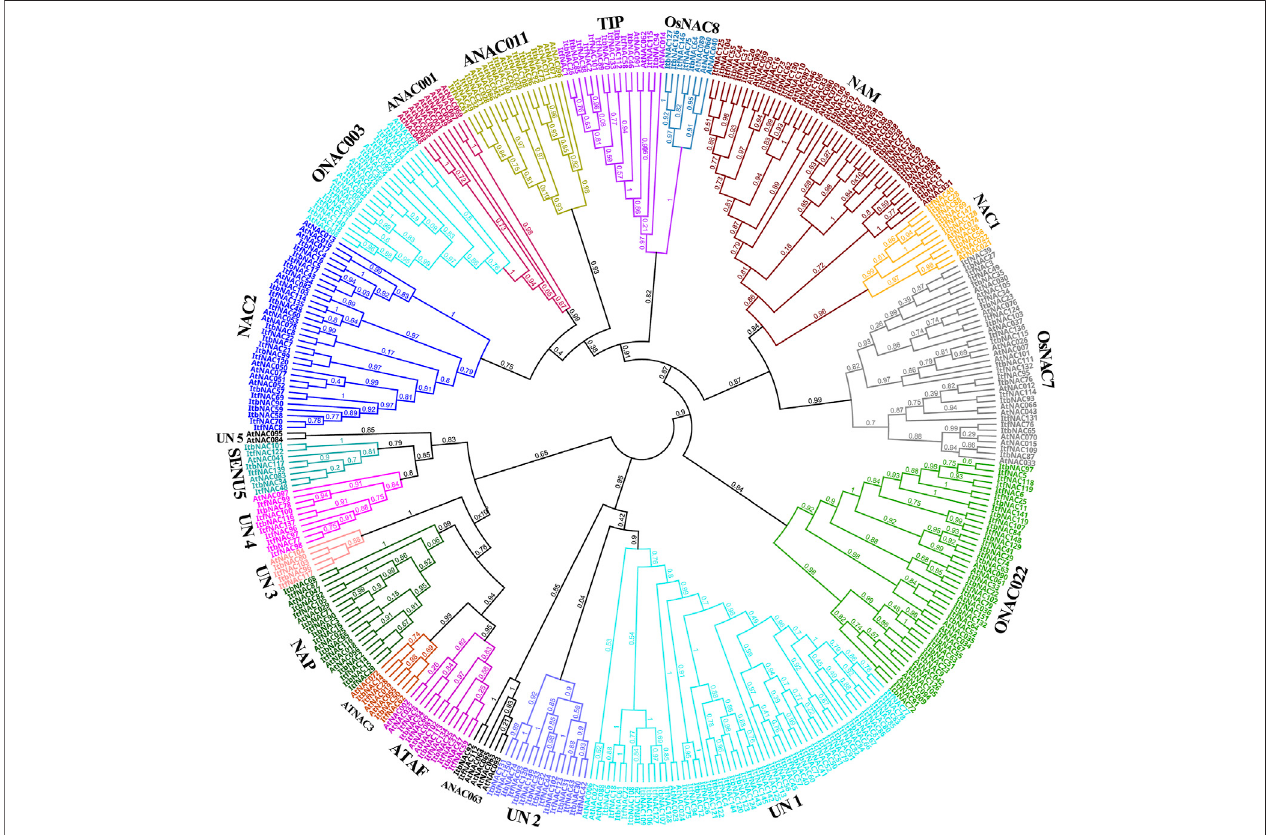
FIGURE1| PhylogenetictreeoftheNACfamilyproteinsfromtwodiploidwildsweetpotatospeciesandArabidopsisthaliana.274NACproteinsfromsweetpotato and 105 representative AtNAC proteins from A. thaliana were used to construct a Neighbor-joining phylogenetic tree by MEGA6.0 software with 1,000 bootstrap replicates. All 274 NAC proteins were classi fi ed into 20